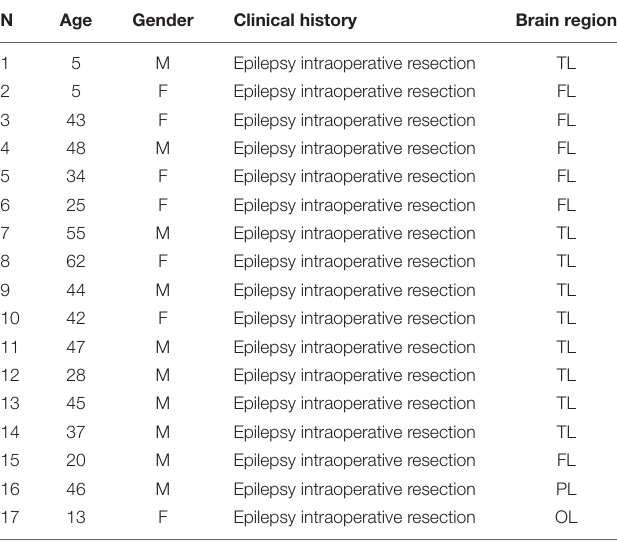
TABLE 2 | Clinical and demographical data of neurosurgical samples